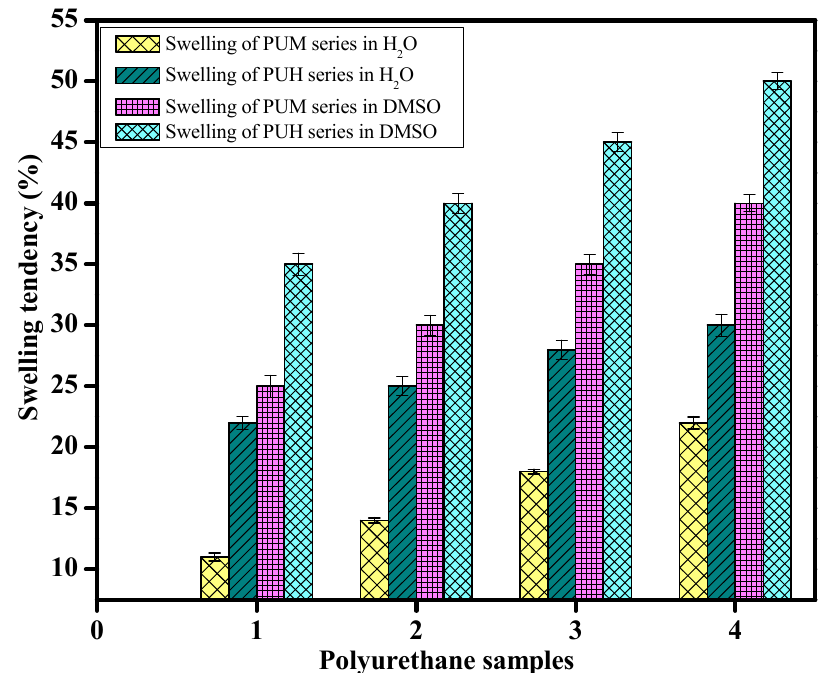
Figure 5. The swelling tendency of GO induced PU composites of the PUM and PUH series.